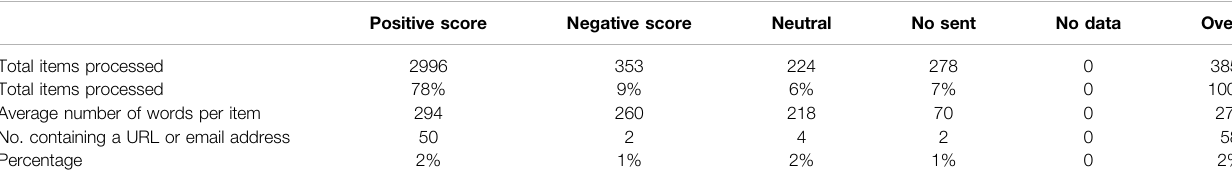
TABLE 4 | Source data analysis.